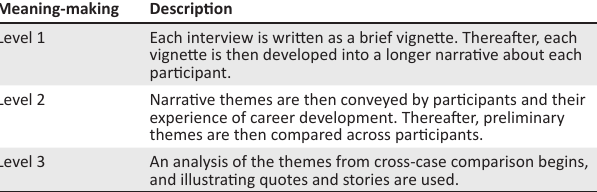
TABLE 2: Data analysis: Levels of meaning-making.